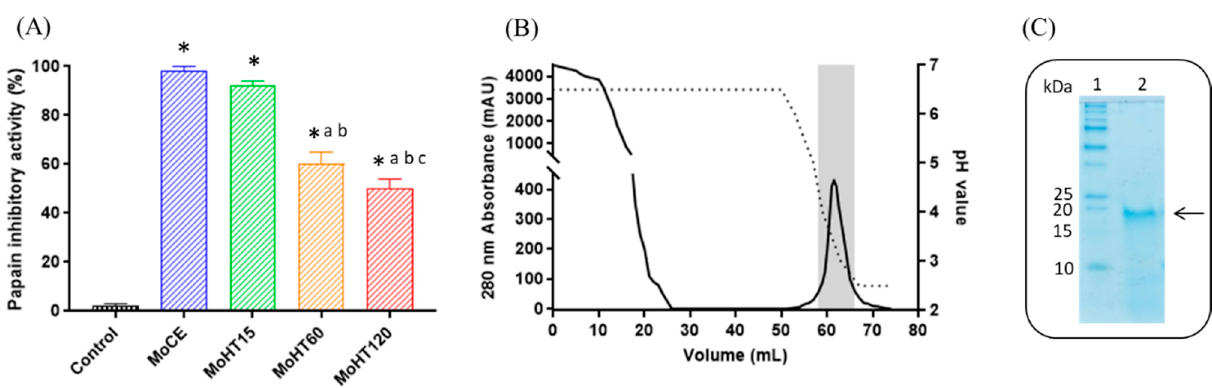
Figure 1. Isolation and purification of M. oleifera papain inhibitor (MoPI) from the crude extract (MoCE). ( A ) Papain inhib-